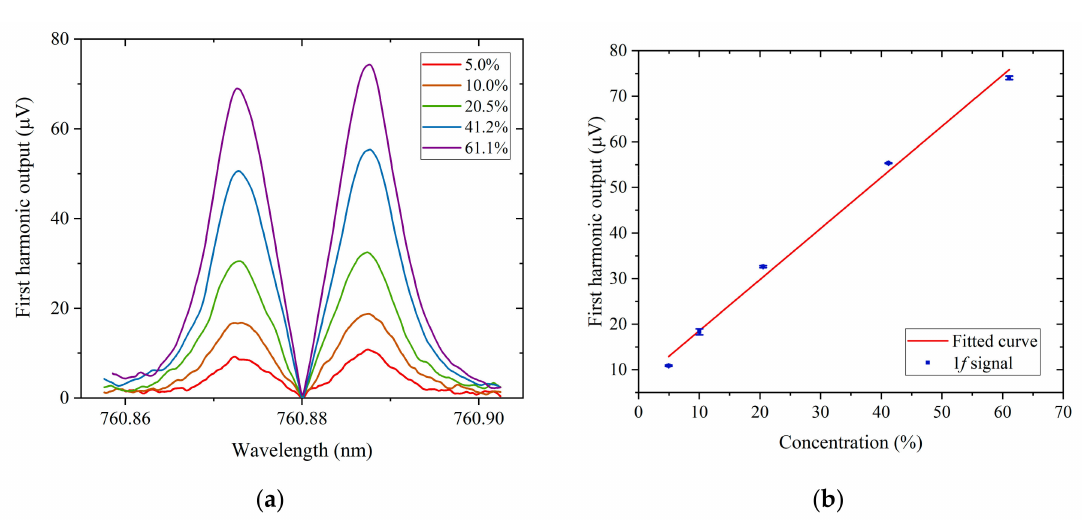
Figure 6. ( a ) First harmonic output signal for 5%, 10%, 20.5%, 41.2% and 61.1% oxygen in nitrogen. ( b ) Peak value of the PT signal as a function of oxygen concentration from 5% to 60%. Error bars show the s.d. of the PT